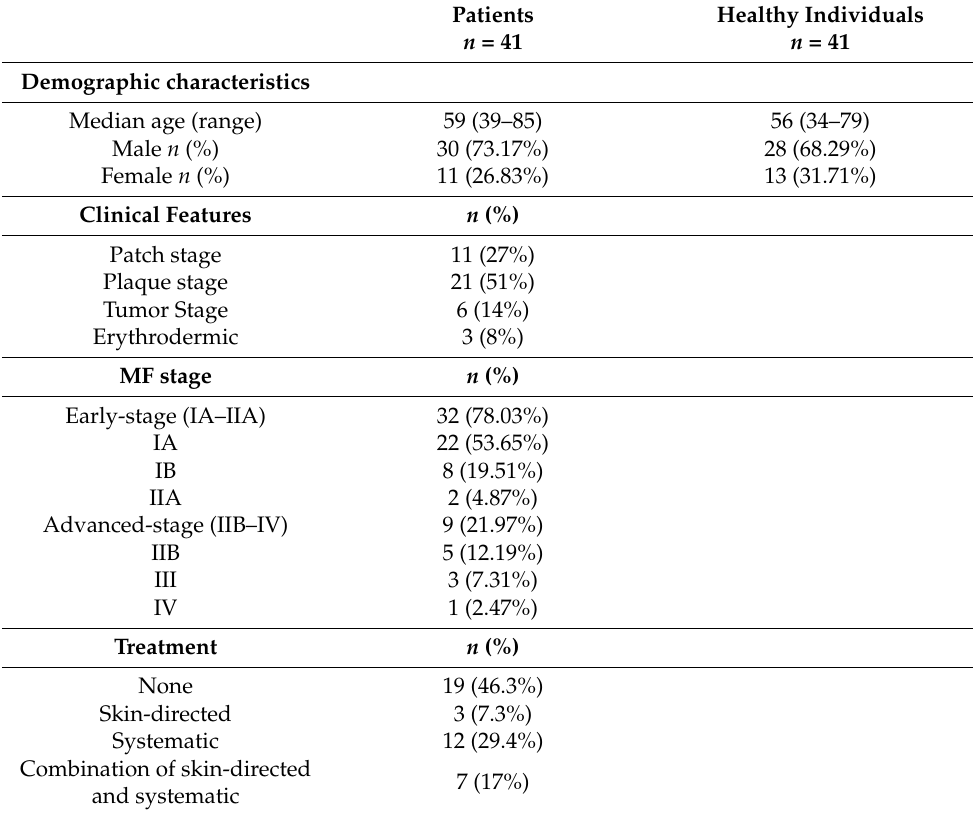
Table 1. Demographic and clinical characteristics of the patients and healthy individuals included in the